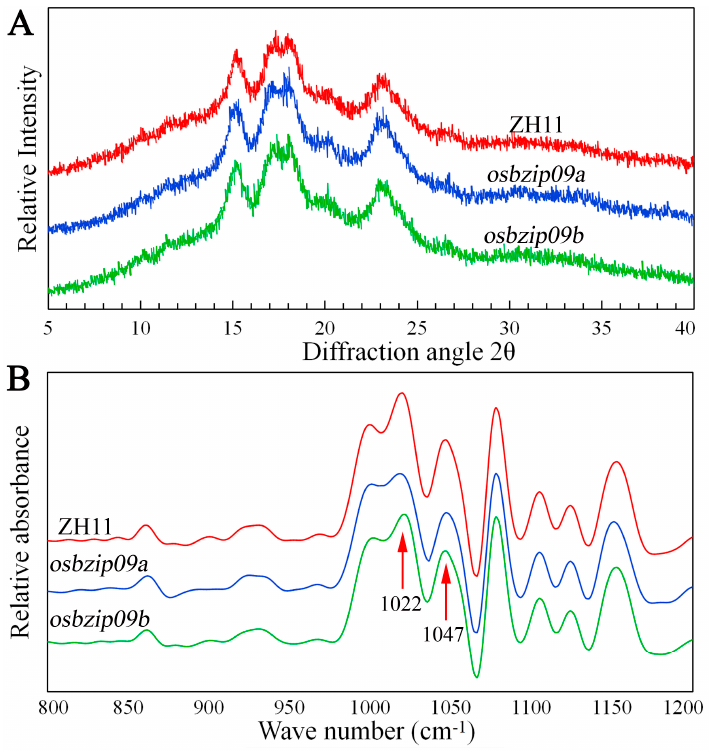
Figure 5. XRD patterns ( A ) and ATR-FTIR spectra ( B ) of rice starches from ZH11 and its mutant lines osbzip09a and osbzip09b .